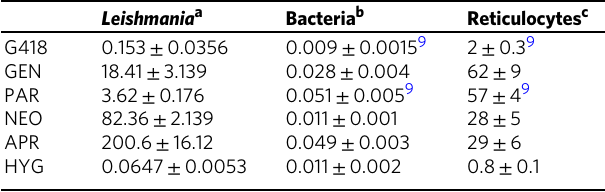
Table 1 In vitro inhibition of translation measured in L. tarentolae a , E. coli b , and rabbit c reticulocyte lysates Inhibition of translation — IC 50 ( μ